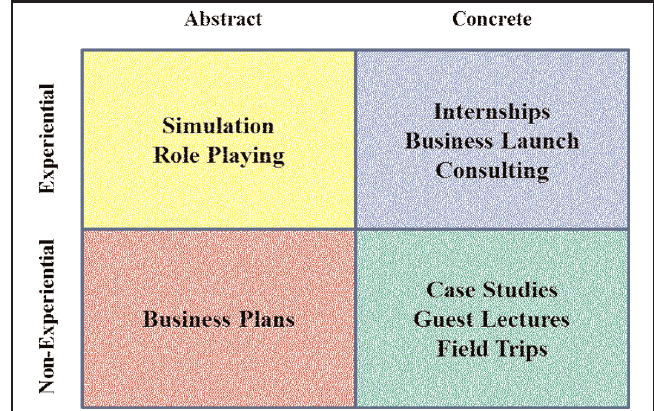
Figure 1: Pedagogical Approaches